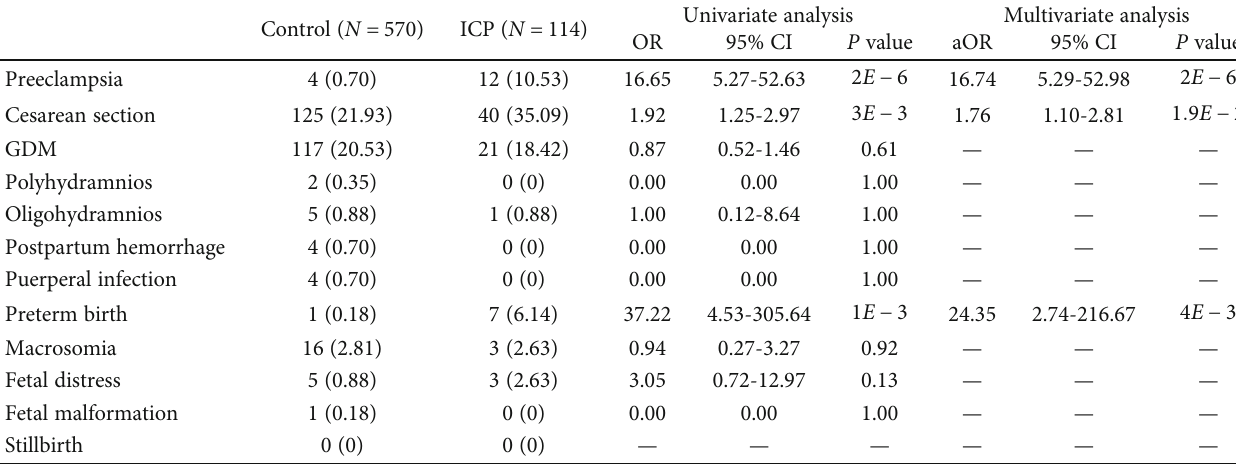
Table 3: Adverse e ff ects in ICP and controls ( n